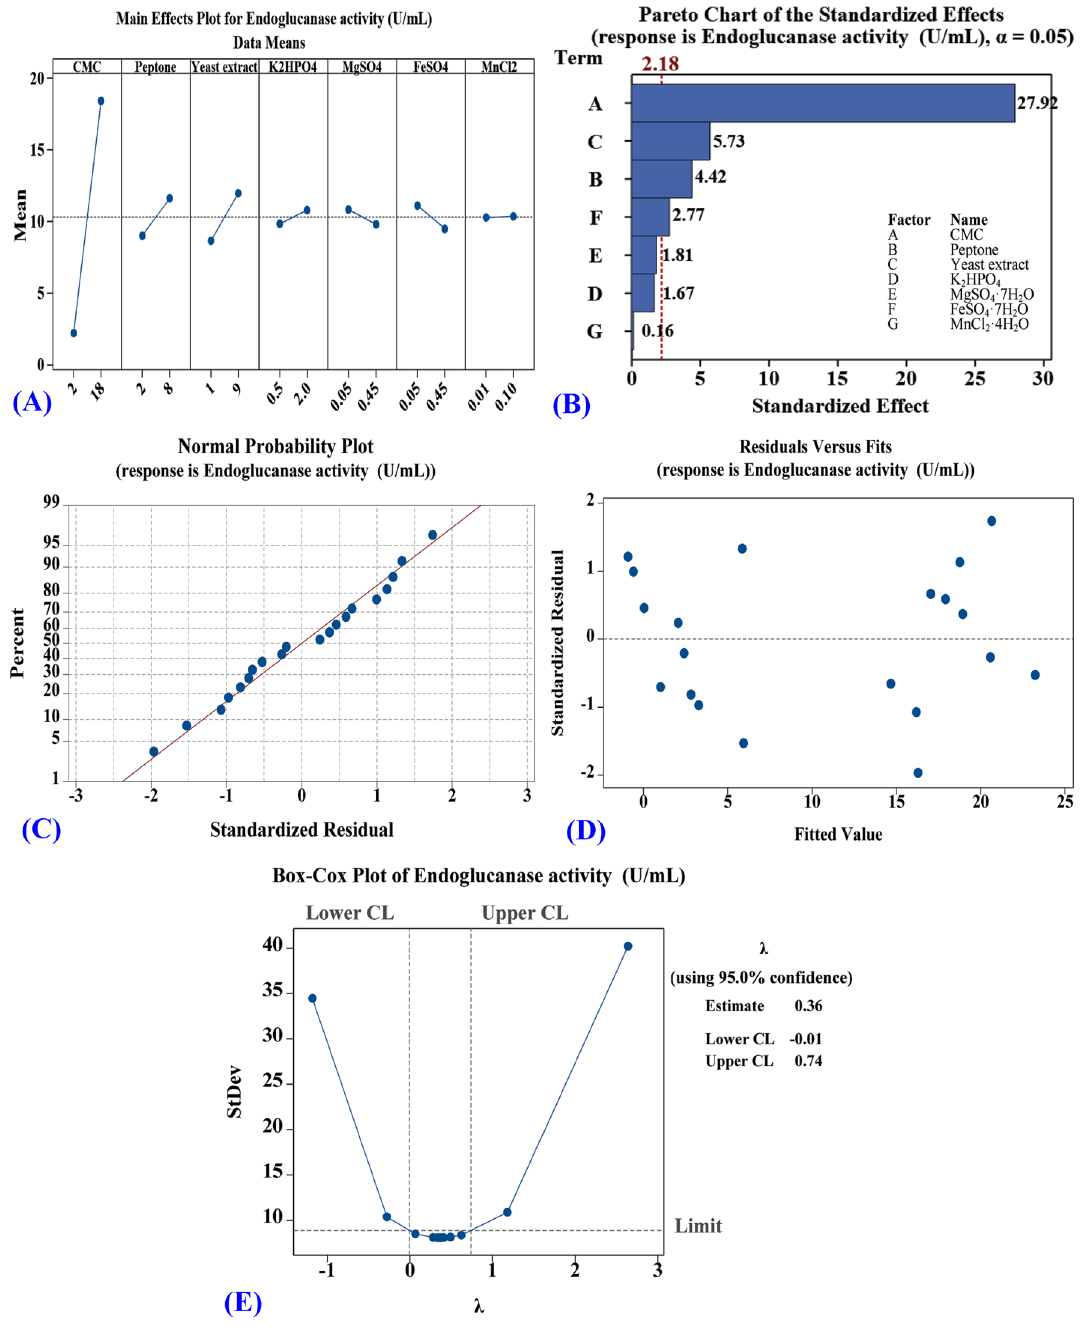
Figure 5. Plackett-Burman design for optimization of endoglucanase production by Bacillus subtilis Fatma/1. A ) Main Effects Plot of the seven independent variables on the mean endoglucanase activity, B ) Pareto chart illustrates the order and significance of the variables, C ) Normal Probability Plot, D ) Residuals vs Fits and E ) Box-Cox Furthermore, the residual analysis (Fig. 5D) obtained by plotting of the observed–predicted values (residuals) vs the response (observed endoglucanase activity) indicated that the residuals were symmetrical and uniformly spread all through the range. The Box-Cox plot for endoglucanase production is shown in Fig. 5E. It revealed that the normal distribu- tion can be achieved using Lambda values between − 0.01 and 0.74. Transformation is not required for the model used for endoglucanase production as lambda value (0.36) falls between − 0.01 and 0.74.